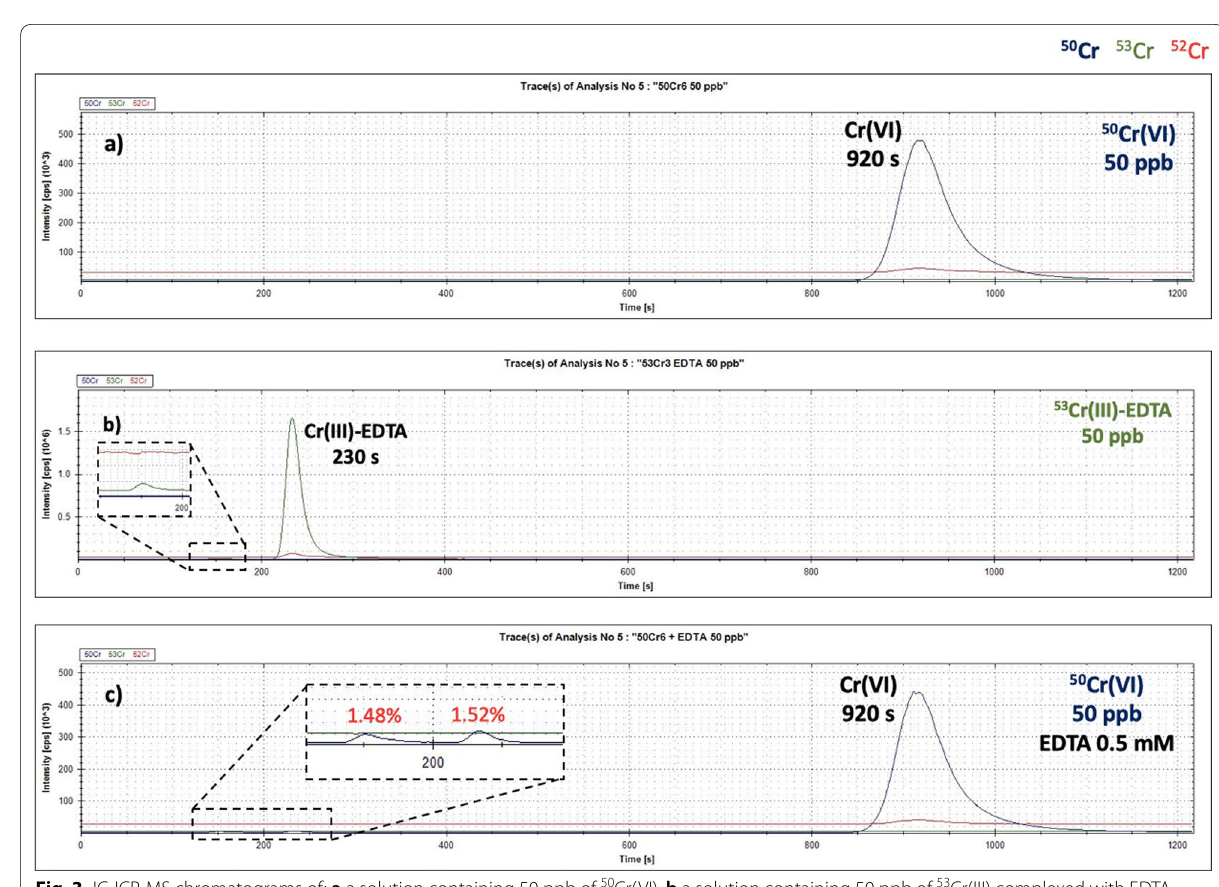
Fig. 3 IC‑ICP‑MS chromatograms of: a a solution containing 50 ppb of 50 Cr(VI), b a solution containing 50 ppb of 53 Cr(III) complexed with EDTA 0.5 mmol/L, and c a solution containing 50 ppb of 50 Cr(VI) and EDTA 0.5